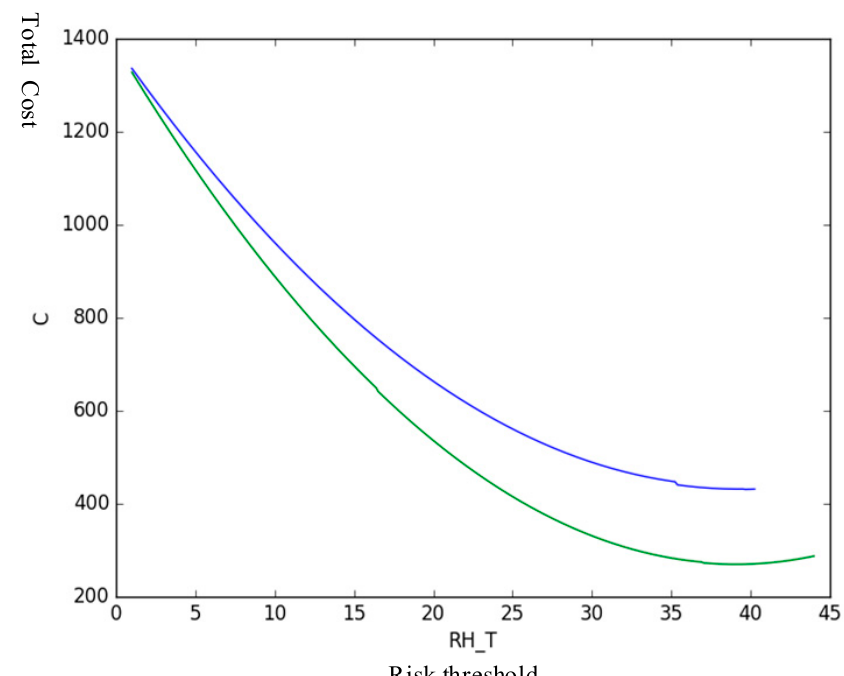
Figure 10. Trends in total costs under two risk thresholds.